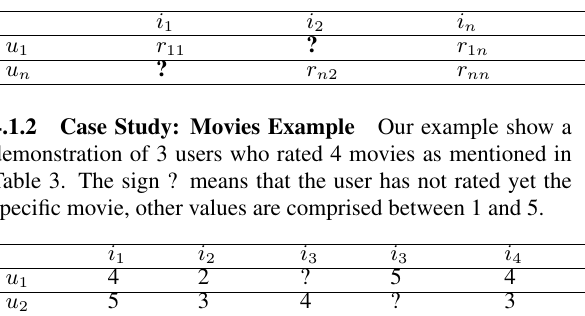
Table 2. User rating matrix representation.